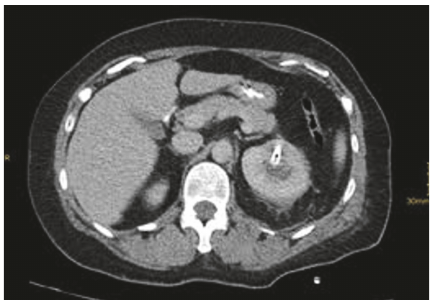
Figure 3: Abdominal CT scan (fourth postoperative day) demon- strating no pathologic findings from pancreas and nephrostomy tube in the left renal